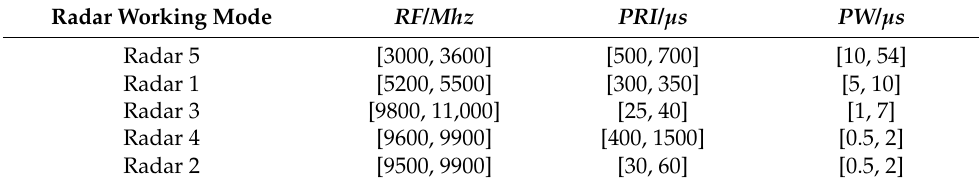
Table 1. Radar working mode attribute range.